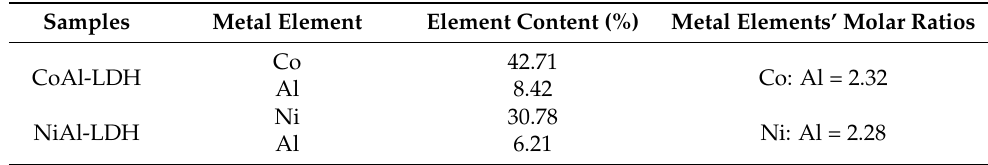
Table 1. The corresponding data from the ICP-OES test.